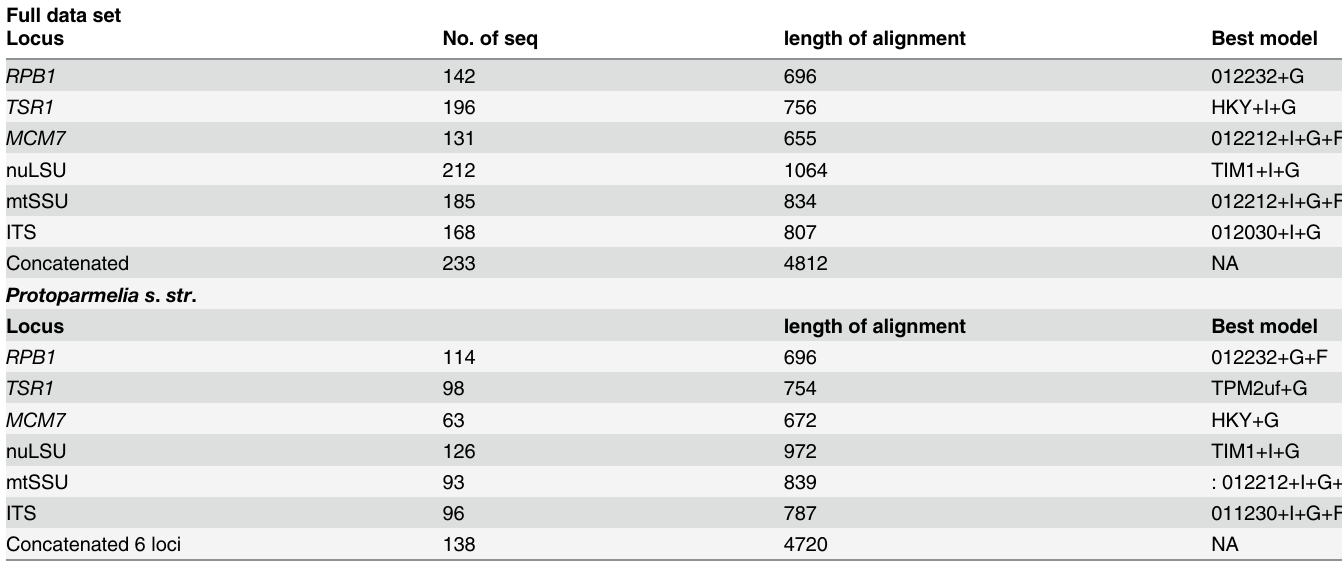
Table 2. Genetic characteristics of nuclear loci used in this study.